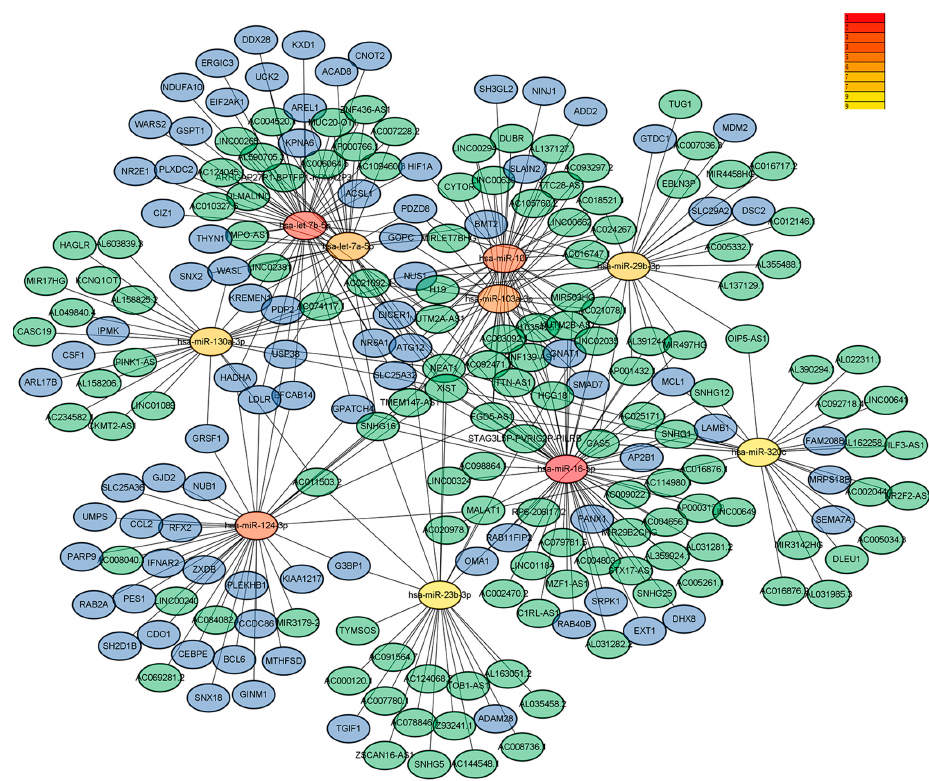
Figure 3. Results of pathway enrichment analysis (multiple miRNAs).